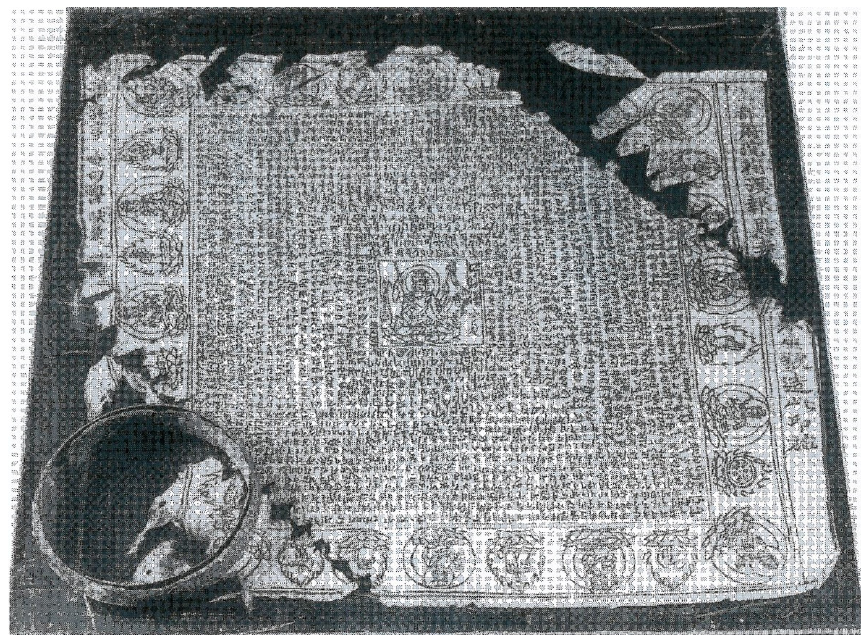
Figure 3. Set of a Mah ā pratisar ā Dh ā ra ṇ ī print and a bronze armlet. Tang dynasty, eighth century. Excavated at Sanjiaozhen, Xi’an City, Shaanxi Province of China. Armlet d. 9.0 cm; print 30.0 × 31.0 cm. After (W. Huo 2011, p. 87, Figure 7).